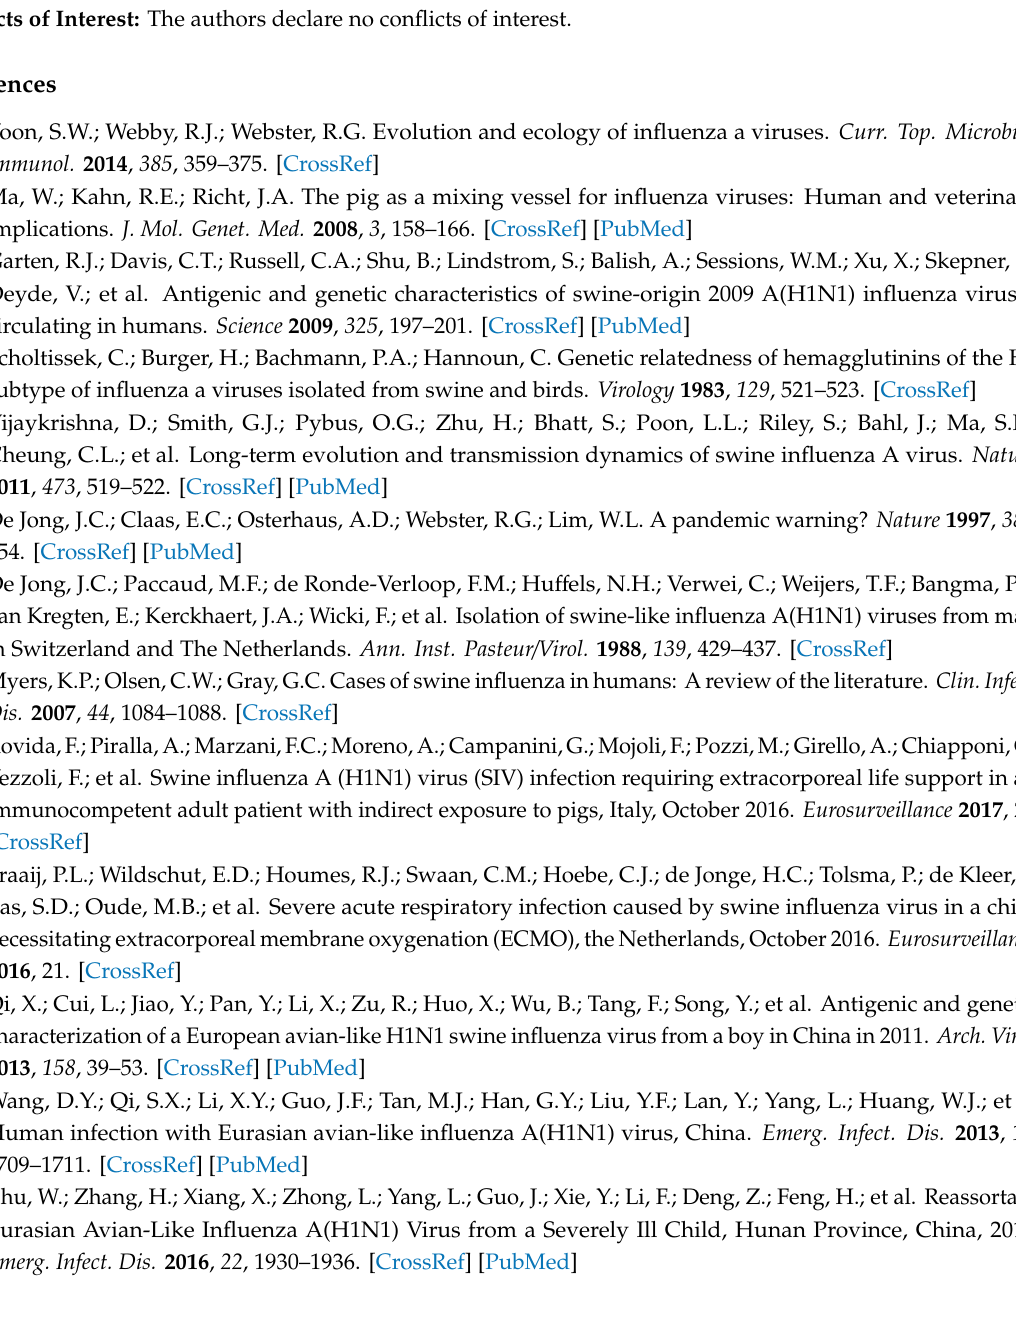
Figure S1: Weight changes and survival rates of mice infected with r / YJ4 and r / YJ4-251R viruses., Figure S2: Growth Kinetics of r / YJ4 and r / YJ4-251R viruses in MDCK and A549 cells at 37 ◦